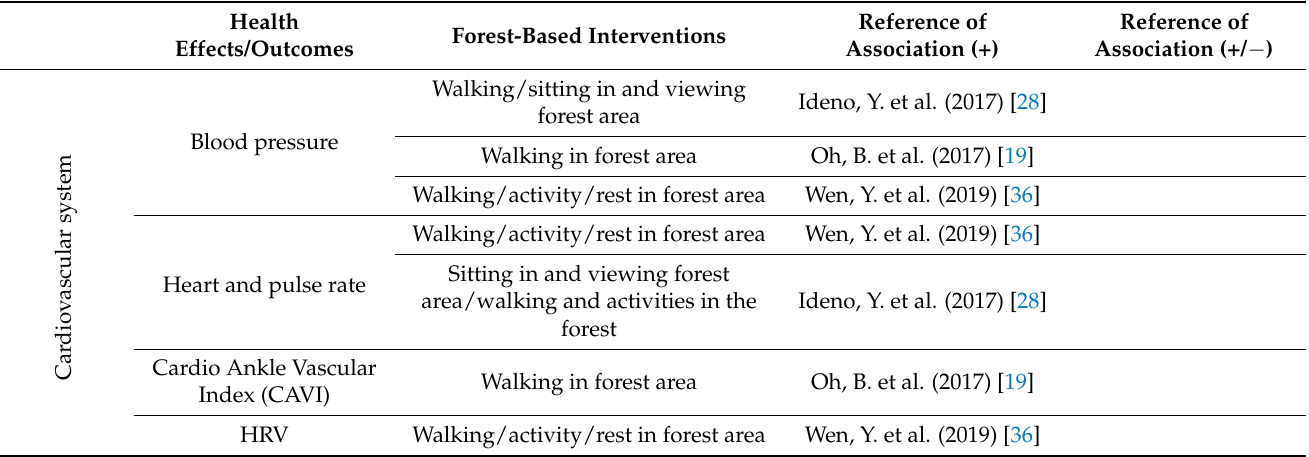
Table 3. Summary of associations between forest-based interventions and health effects/outcomes on the cardiovascu- lar